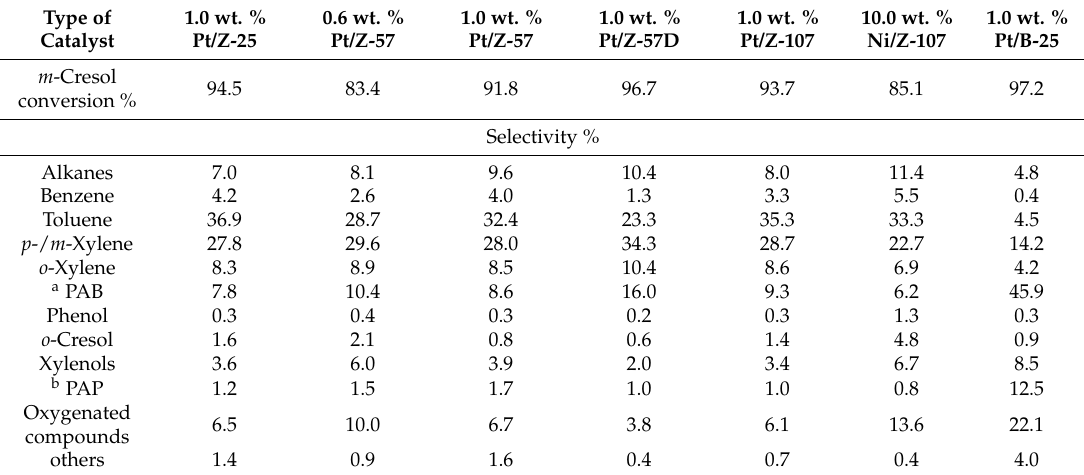
Table 3. Effect of catalysts on the product distribution from converting m- cresol with methanol. Type of